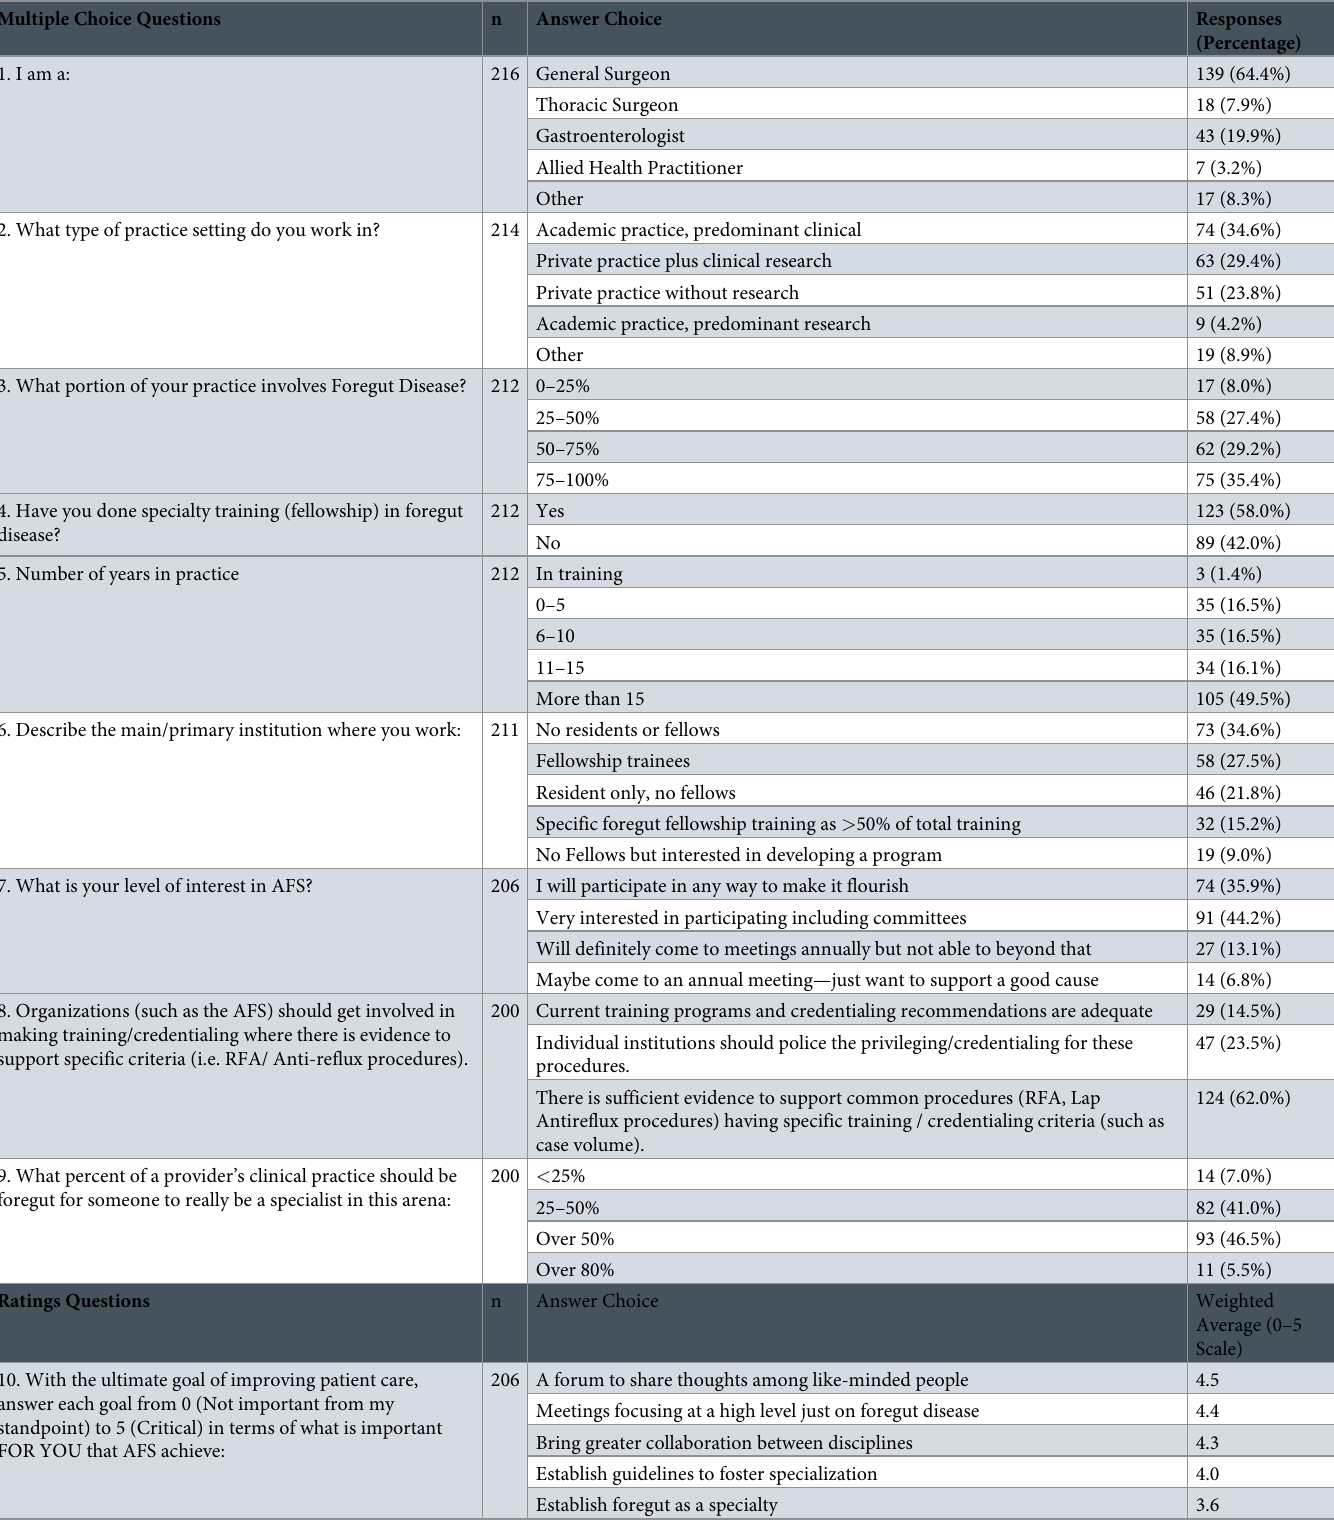
Table 1. Survey results from AFS inaugural